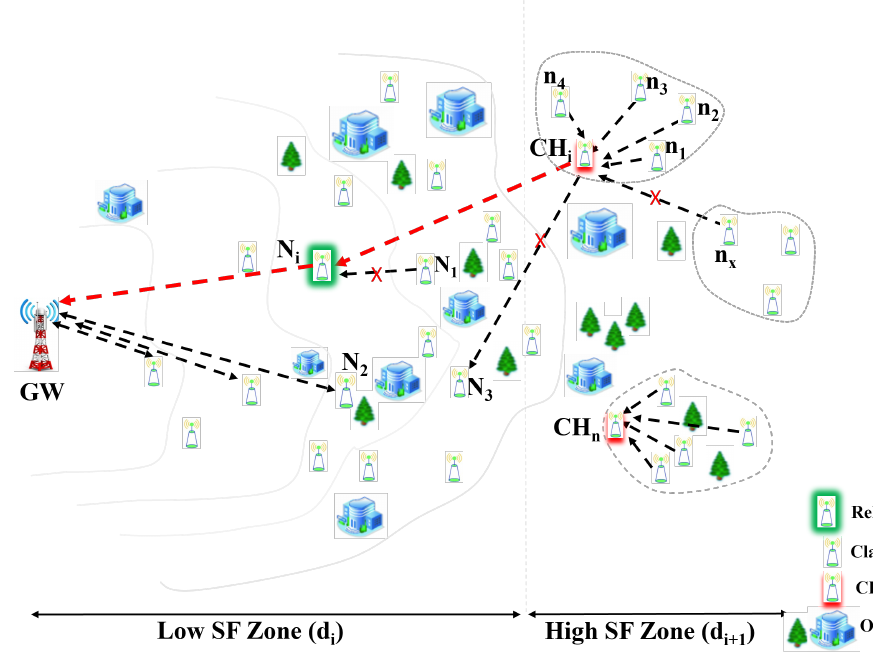
Figure 2. Model of the relay and cluster process in the proposed SFPCR